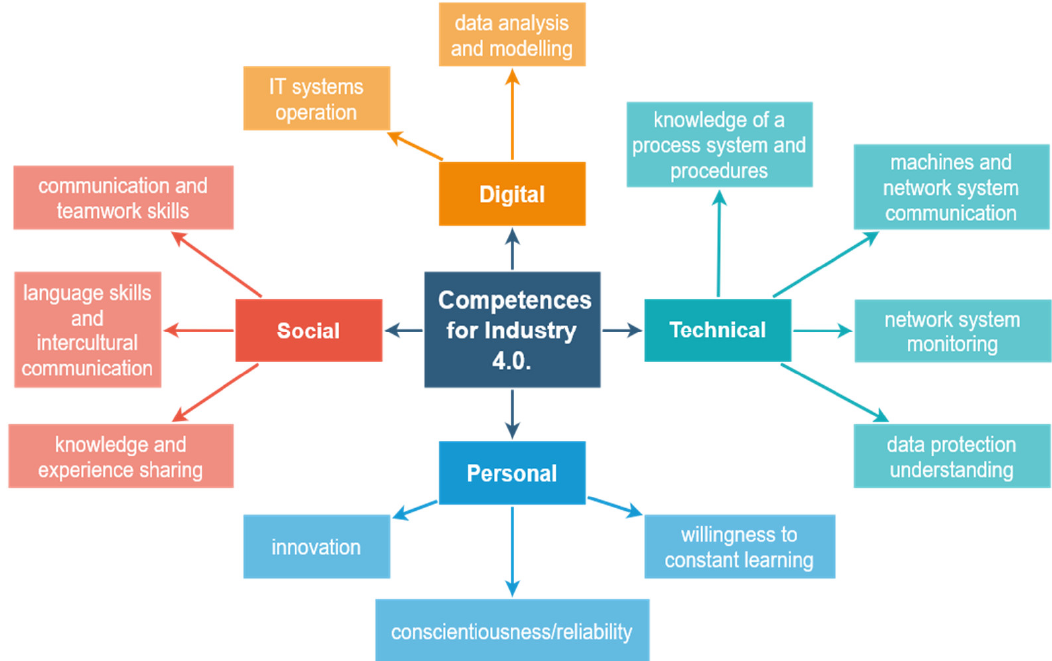
Figure 7. Competencies of employees in Industry 4.0 conditions. Source: own elaboration.